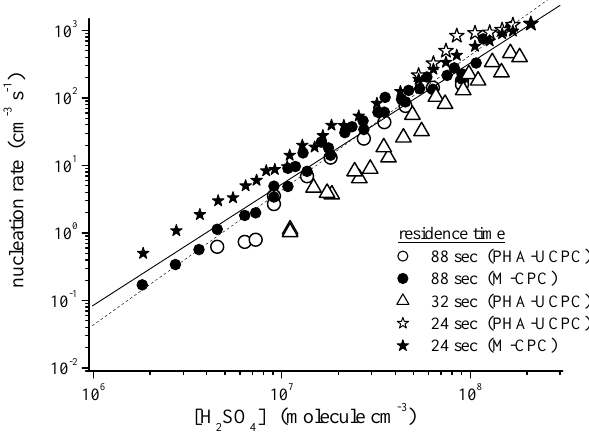
Fig. 5. Nucleation rate as a function of H 2 SO 4 concentration for different residence times in the irradiated middle section of the IfT - LFT; RH=22%. Measurements have been performed by means of PHA-UCPC and M-CPC. Full line represents the overall best fit according to Eq. (1), dashed line stands for the fitting result con- straining the exponent for H 2 SO 4 at